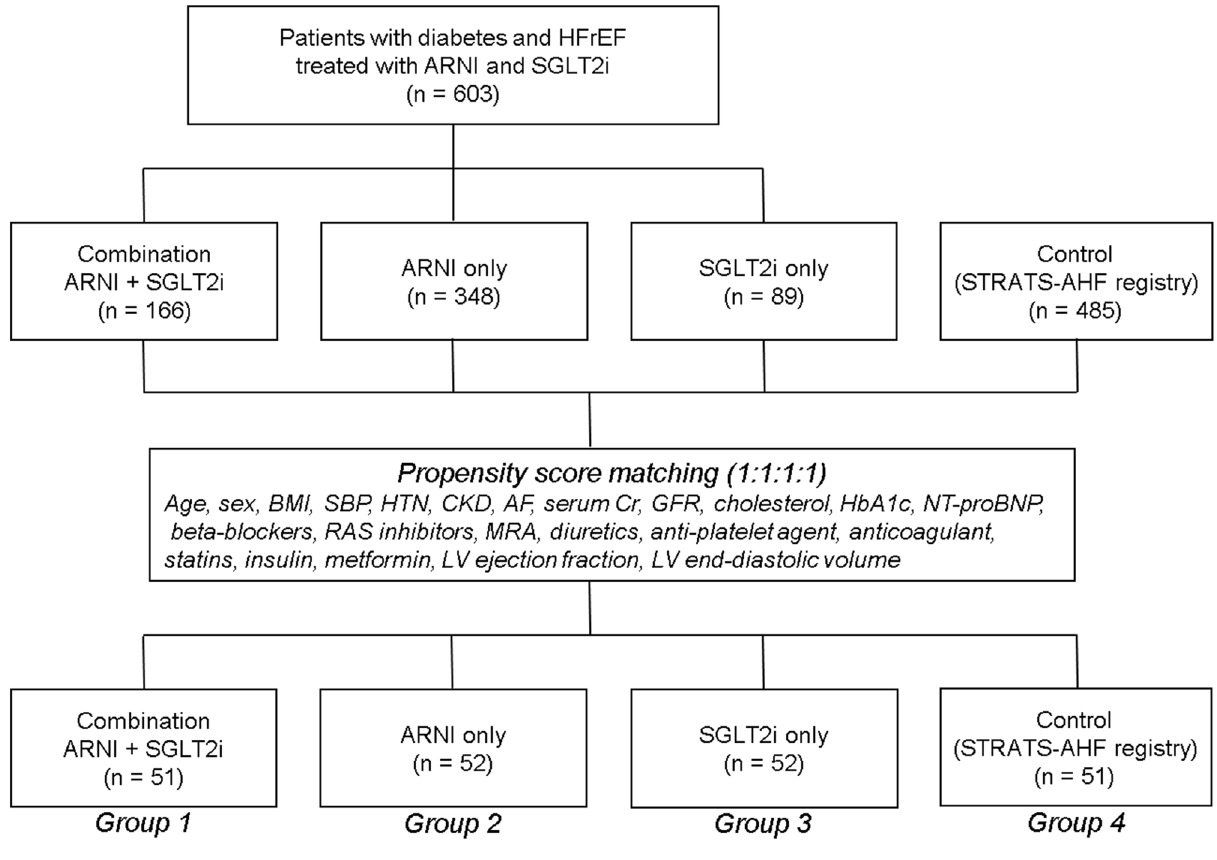
Figure 1. Flowchart of the study